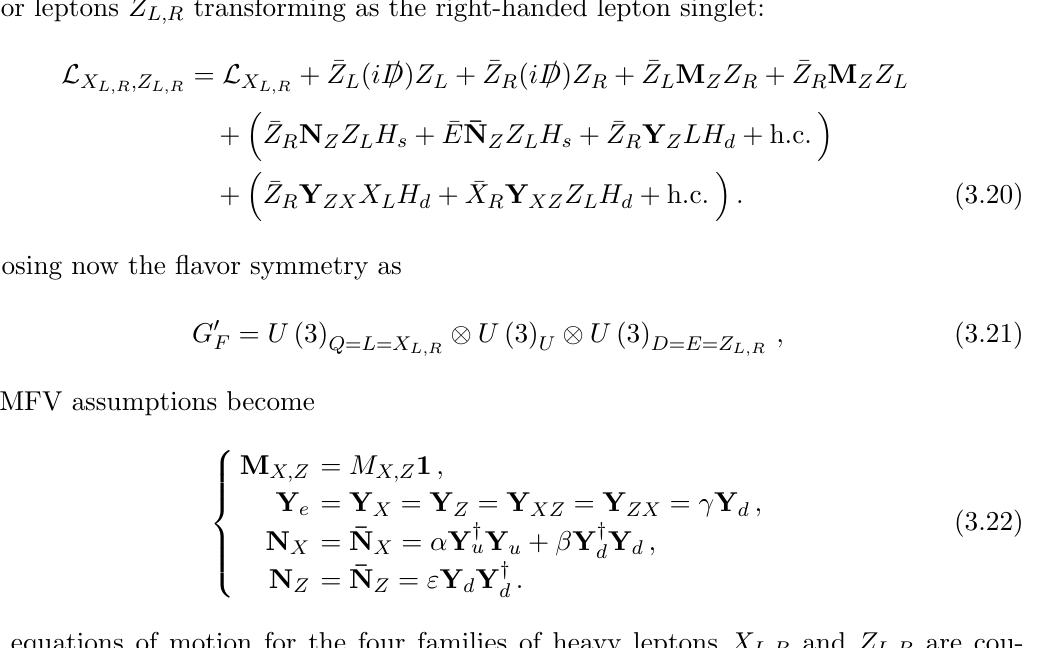
vector leptons Z transforming as the right-handed lepton L;R